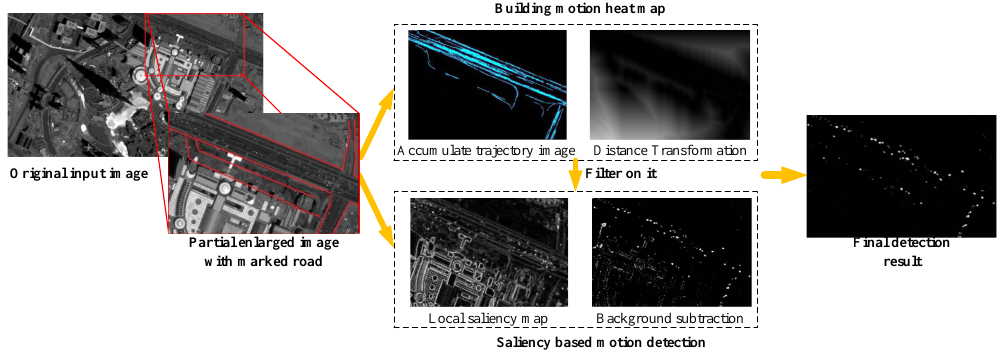
Figure 2. The proposed framework. The partial original satellite image is enlarged with red lines as marked roads. The proposed method contains two steps: building motion heat map and saliency based motion detection. In addition, the main process results of the two steps are